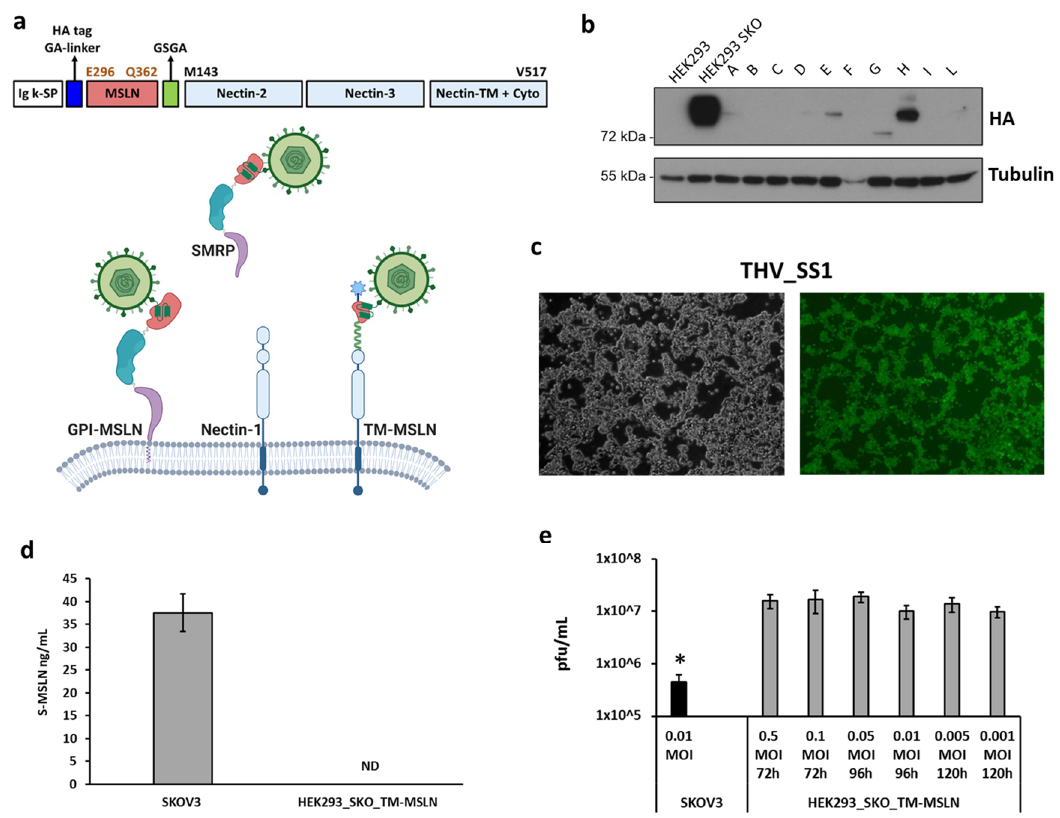
Figure 6. Generation of oncolytic virus HEK293 STING KO producing cell line stably expressing an engineered non- secretable MSLN. ( a ) In the upper part is shown the chimeric MSLN-Nectin construct that consists of: Ig- κ signal peptide (white box), HA tag plus GA-based linker (blue box), the N-terminus 66 amino acid fragment of MSLN (E296-Q362) (red box), GSGA-based linker (green box), the C-terminus of Nectin-1 including the transmembrane and intracellular tail (M143-V517) (light-blue boxes). In the bottom part is shown a cartoon model that depicts the interaction of THV_SS1 with GPI-MSLN, SMRP, TM-MSLN proteins. Created by Biorender. ( b ) Western blot screening for HA tag to find TM-MSLN protein positive clones; clone H was chosen, and gamma-tubulin was used as standard. ( c ) HEK293_SKO_TM-MSLN cell line were efficiently infected by THV_SS1 at 0.005 MOI. ( d ) The secreted MSLN in SKOV3 and HEK293_SKO_TM-MSLN was quantified by ELISA assay. ( e ) The productivity of THV_SS1 was evaluated in SKOV3 at 0.01 MOI and in HEK293_SKO_TM-MSLN at different MOI (from 0.001 to 0.5). The statistical significance was calculated by Student’s t -test and resulted as not significant, comparing the different MOI in HEK293_SKO_TM-MSLN cells (0.5, 0.1, 0.05, 0.01, 0.005, 0.001 MOI). The difference between SKOV3 and HEK293_SKO_TM-MSLN resulted as significant ( p < 0.05